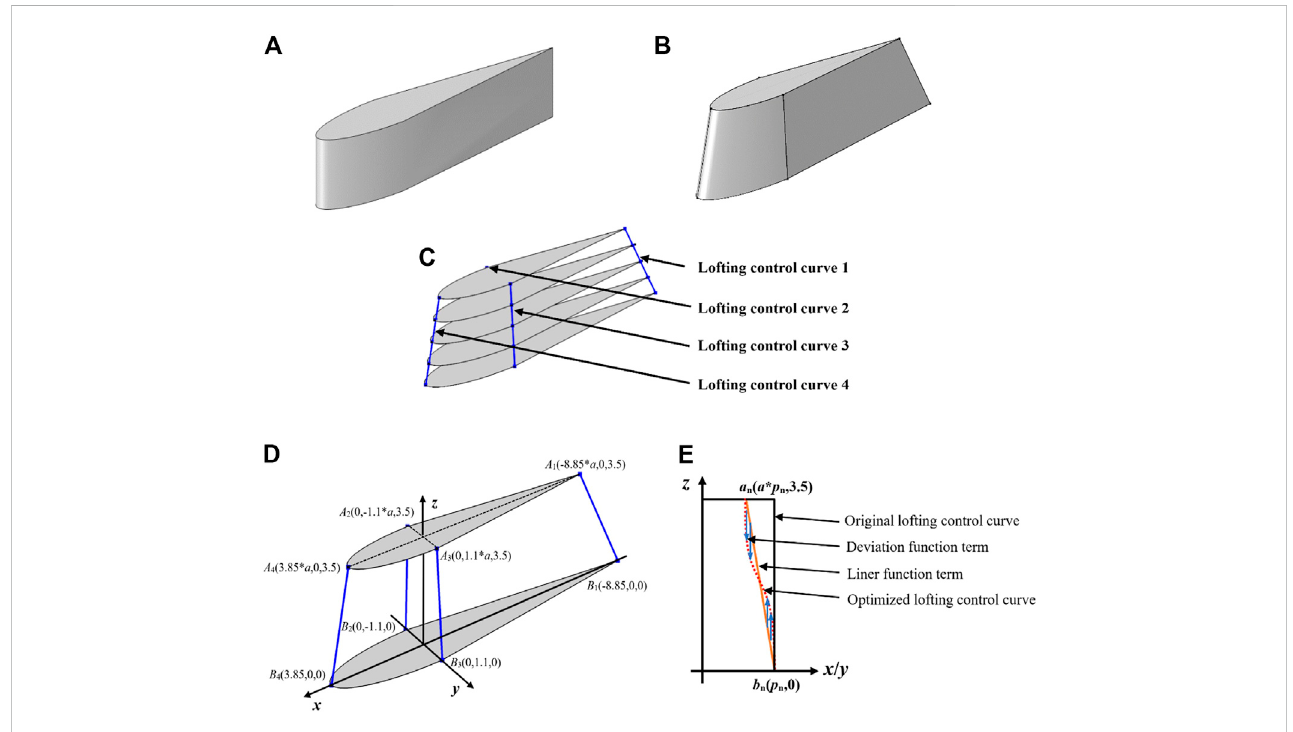
FIGURE 4 Basic idea of conning tower parametric modeling in the optimization process. (A) Original benchmark conning tower. (B) Optimized conning tower. (C) Lofting control curve of the conning tower. (D) Key points of 3D lofting control curve optimization. (E) Two-dimensional deviation